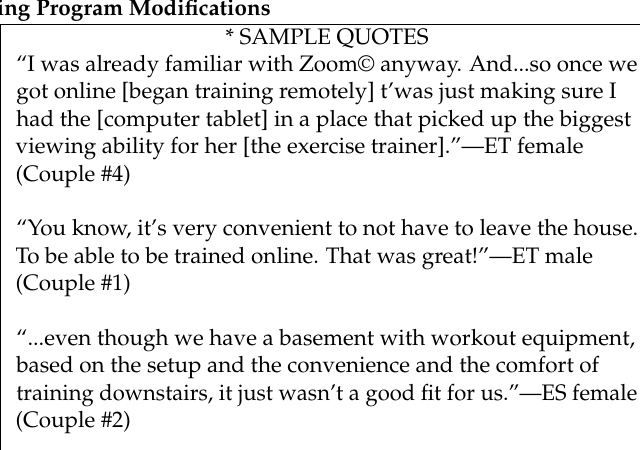
Table 3. Identified themes, categories, and sub-categories related to the interruption of the exercise intervention ( N =